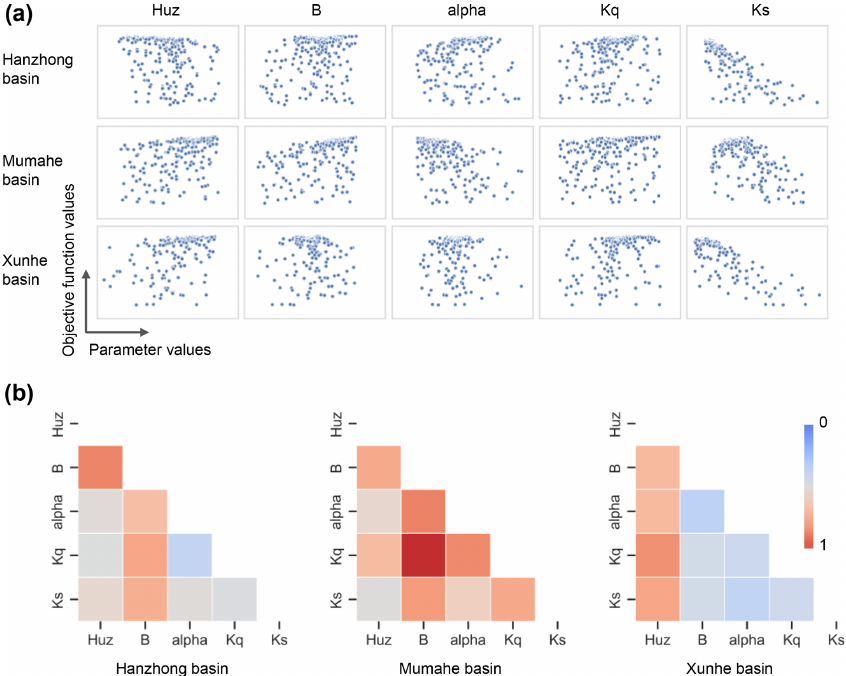
Figure 4. (a) Sensitivity analysis results using scatter plots. The horizontal axis represents the sampling points, which are the parameter sets. The vertical axis represents their objective function values. (b) The linear or nonlinear correlations between the parameters based on MICs. Red denotes the strongest correlation between